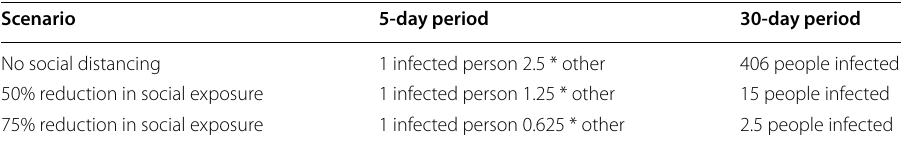
*For estimations only. It is not possible to infect only a fraction of another person